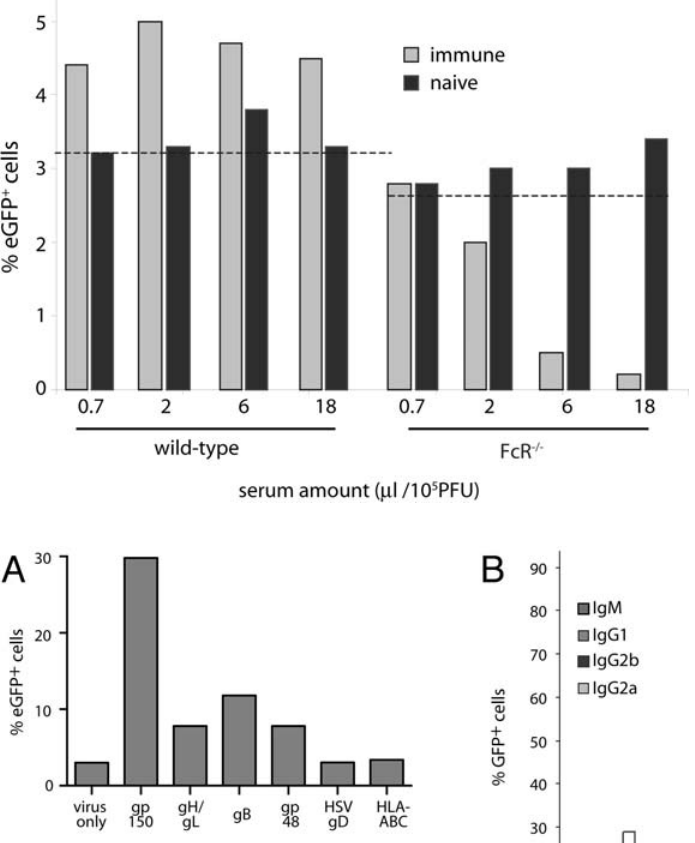
Figure 2. The effect of immune serum on macrophage infection depends on IgG Fc recep- tors. Wild-type and FceRI c 2 / 2 Fc c RIIB 2 / 2 (FcR 2 / 2 ) bone marrow-derived macrophages were incubat- ed overnight with BAC + MHV-68 (5PFU/cell) that had been preincubated with dilutions of serum from either naive or MHV-68-immune mice, and then analyzed for viral eGFP expression by flow cytometry. The dashed lines show the level of infection with no antibody. The data are from 1 of 3 equivalent experiments.